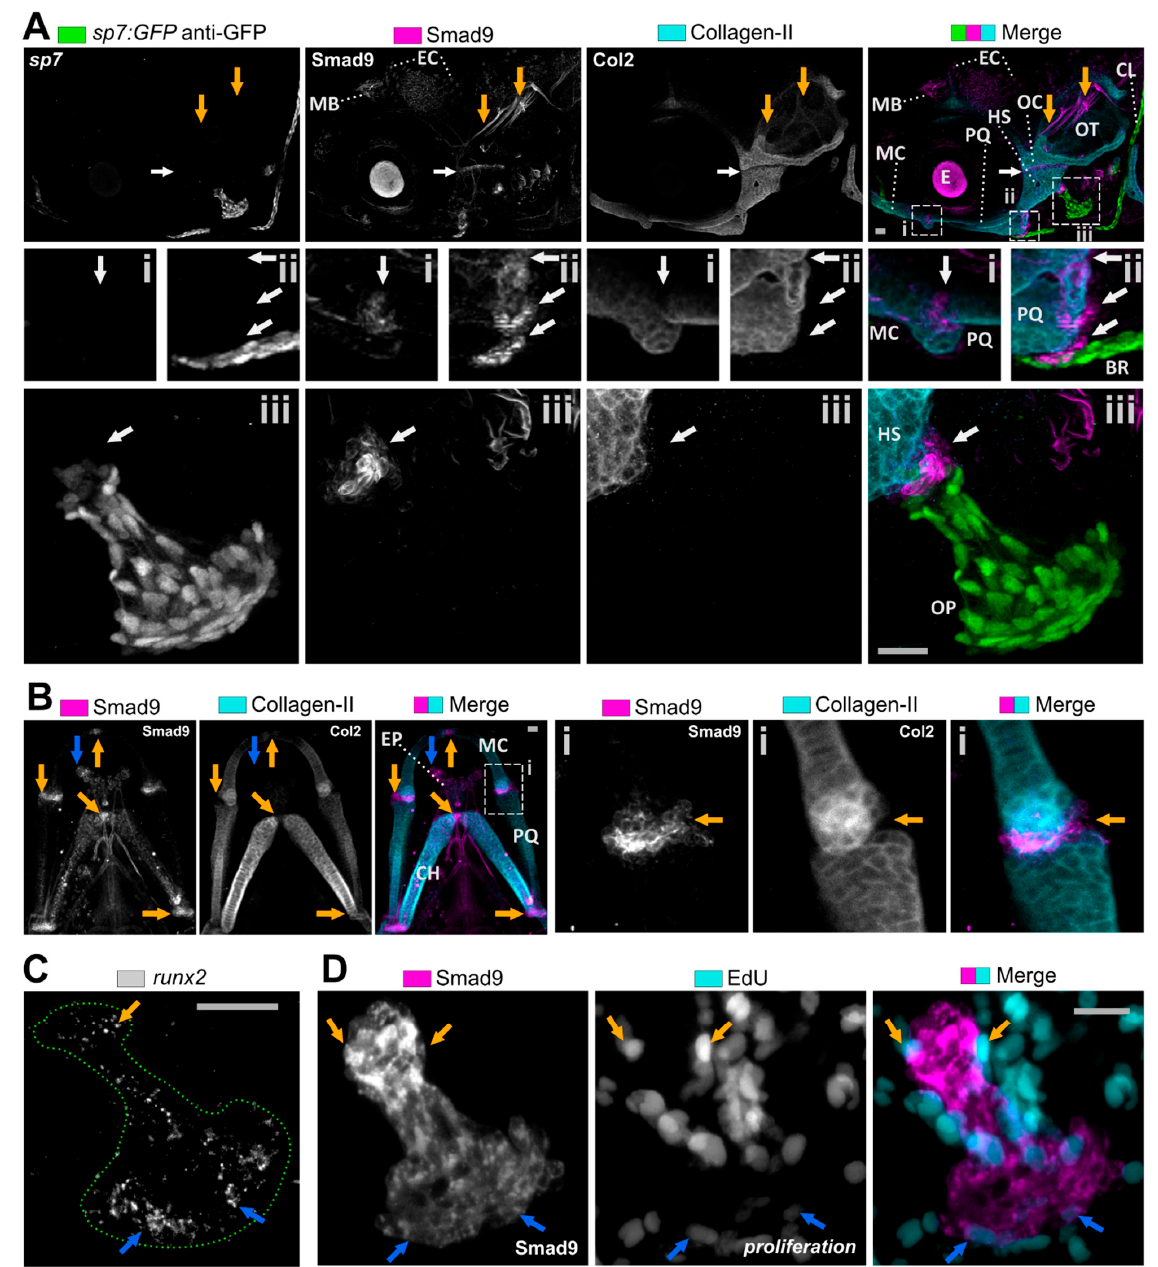
Figure 2. Smad9 is expressed in cell populations marking joint symphyses and interfaces of cartilage and bone of the craniofacial skeleton. ( A ) Lateral view of 4 dpf individual showing Smad9 expression in the craniofacial skeleton in cell populations located at joint symphyses of otic cartilage (OC) and PQ (white arrow) and PQ and MC (inset i), and at cartilage and bone interfaces (inset ii and iii, white arrow). Smad9 expression was also observed in cranial nerves (orange arrow), mid brain (MB) and subpopulations of epidermal cells (EC). ( B ) Ventral view of the lower jaw (5 dpf) showing continued expression of Smad9 at the joint symphyses (orange arrows) and more dorsally located ethmoid plate (blue arrow). Inset (i) shows the MC and PQ symphysis with Smad9 expression not overlapping type II collagen expression (orange arrow). ( C ) Expression of runx2a was predominantly, but not exclusively, seen at the top (orange arrow) and posterior edge (blue arrow) in the operculum (green dotted line) by using in situ hybridisation. ( D ) Visualisation of proliferation by EdU click-iT predominantly showed proliferation adjacent to Smad9 expression near the top (orange arrows) and posterior edge (blue arrows) of the operculum. BR, branchiostegal ray; CH, ceratohyal; CL, cleithrum; E, eye; EC, epidermal cell; EP, Ethmoid plate; HS, hyosymplectic cartilage; MB, mid brain; MC, Meckel’s cartilage; OC, otic cartilage; OP operculum; OT, otolith; PQ, palatoquadrate. Scale bar is 50 µ